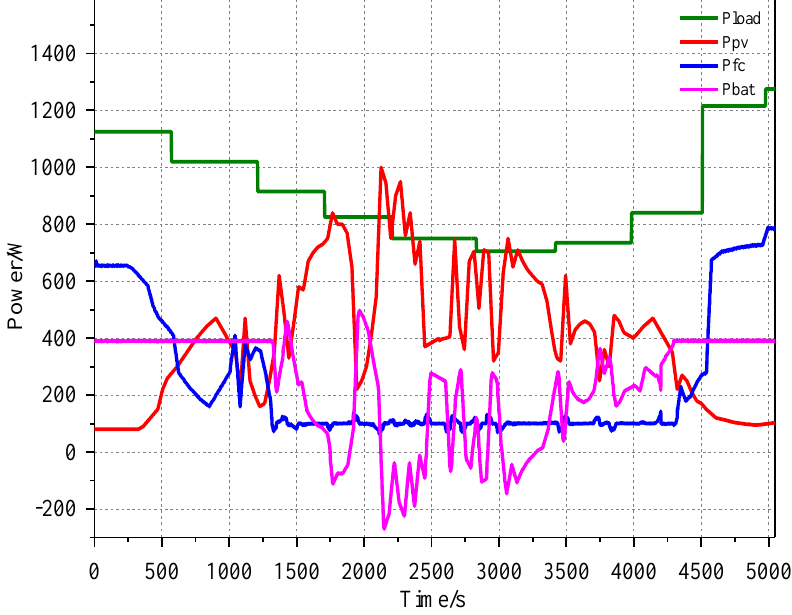
Figure 13. Power flow of the DC microgrid with initial SOC at 95%.